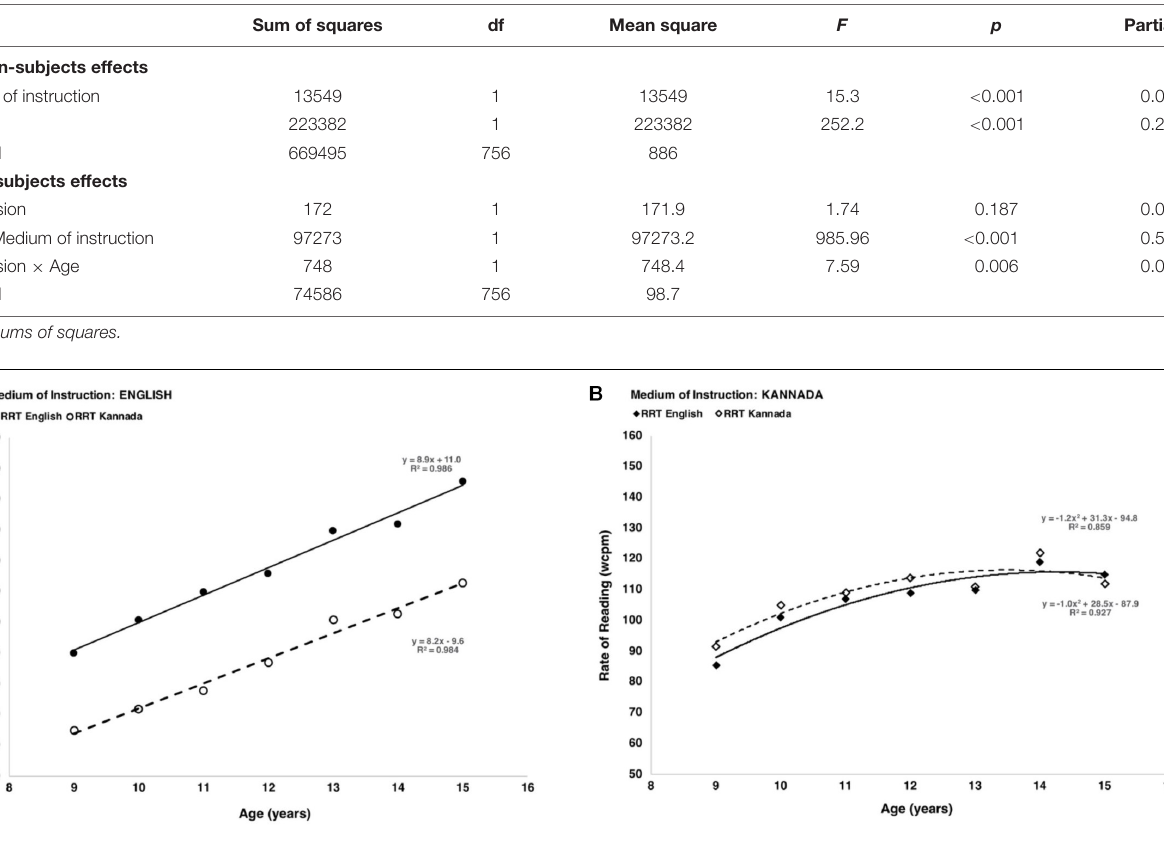
Frontiers in Psychology |